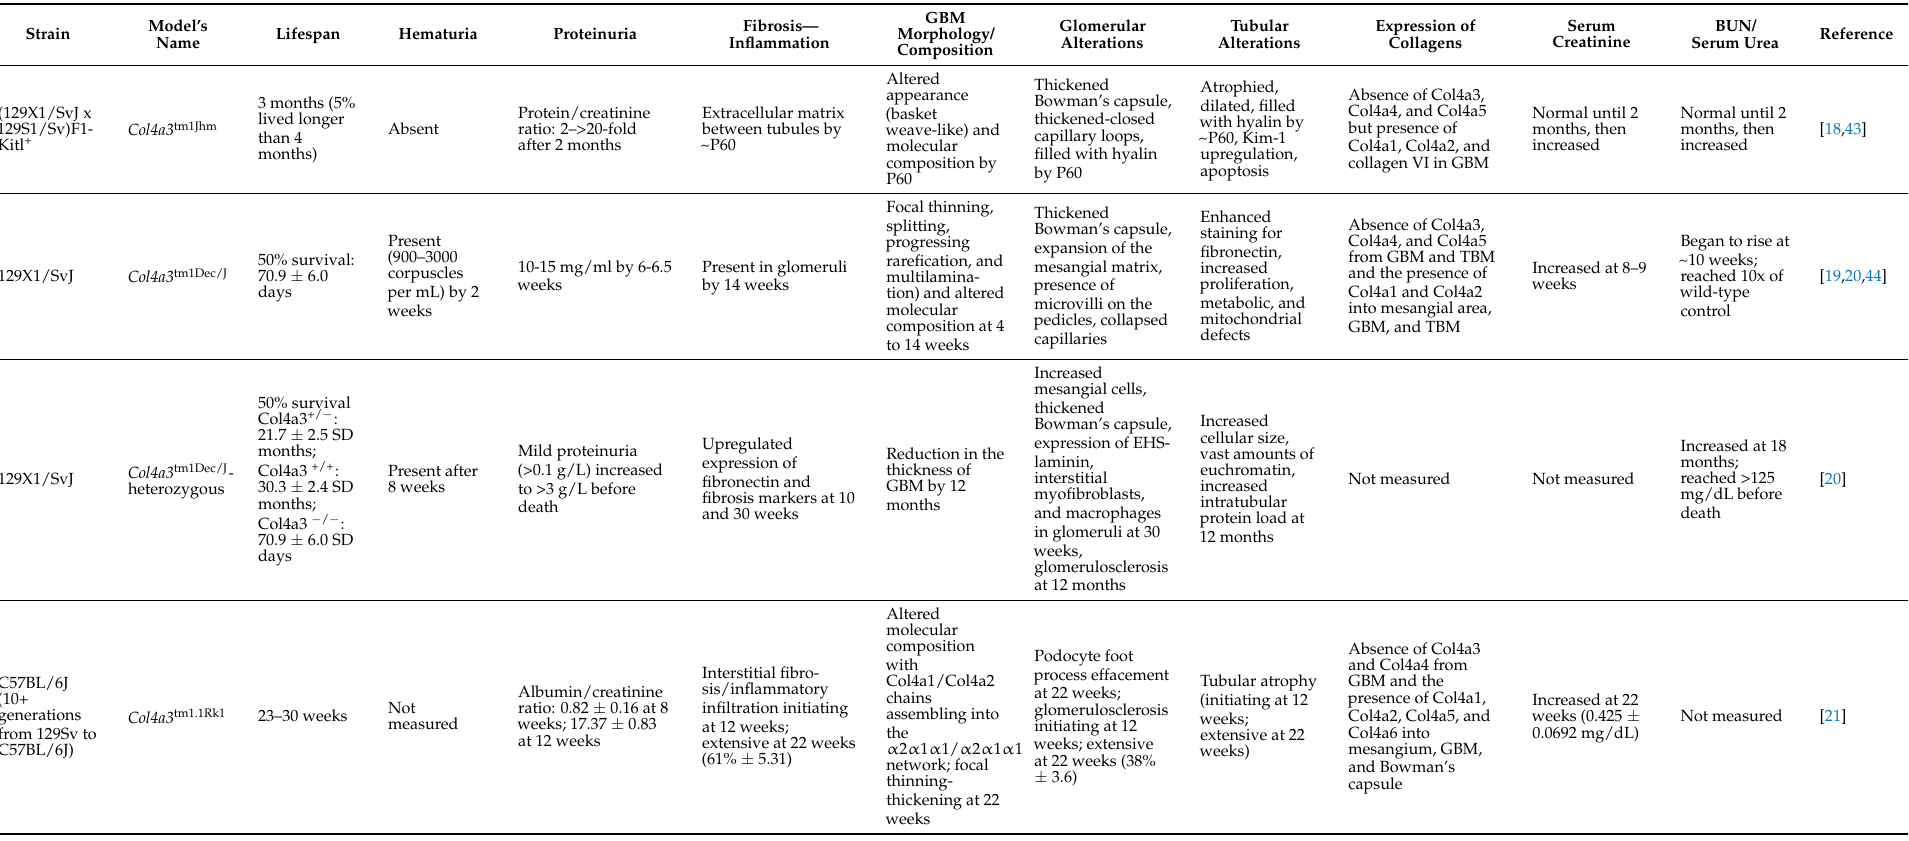
Table 2. Lifespan and kidney-related phenotypic features in mouse models of Alport syndrome. GBM: glomerular basement membrane; TBM: tubular basement membrane; RBCs: red blood